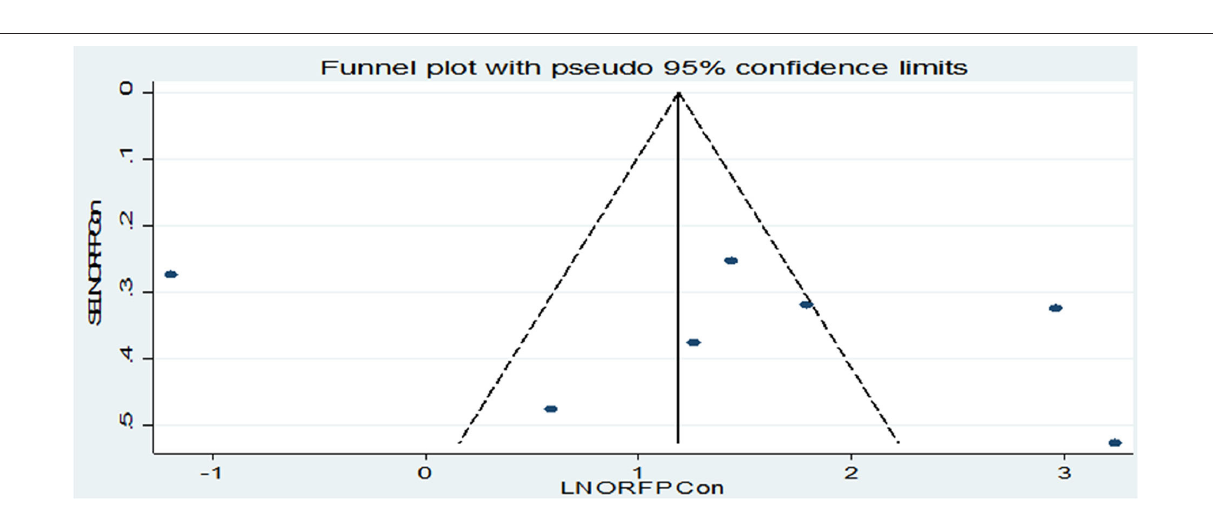
of utilization of post-abortion contraceptives which